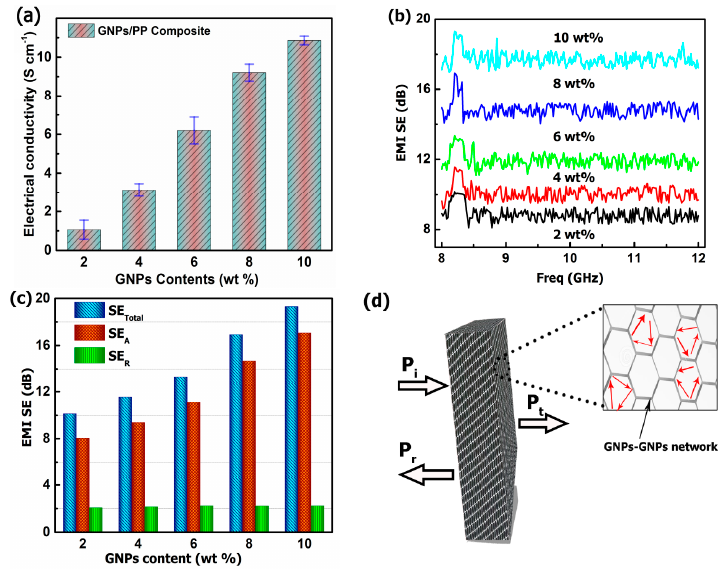
Figure 3. ( a ) Electrical conductivity of the GNPs/PP composite and their comparison with previous work at different loading amounts ( b ) EMI SE of GNPs/PP composite as function of frequency (X-band) ( c ) the comparison of SE Total SE A and SE R at different loading amount of GNPs ( d ) schematic representation of microwave transfer across the composite.